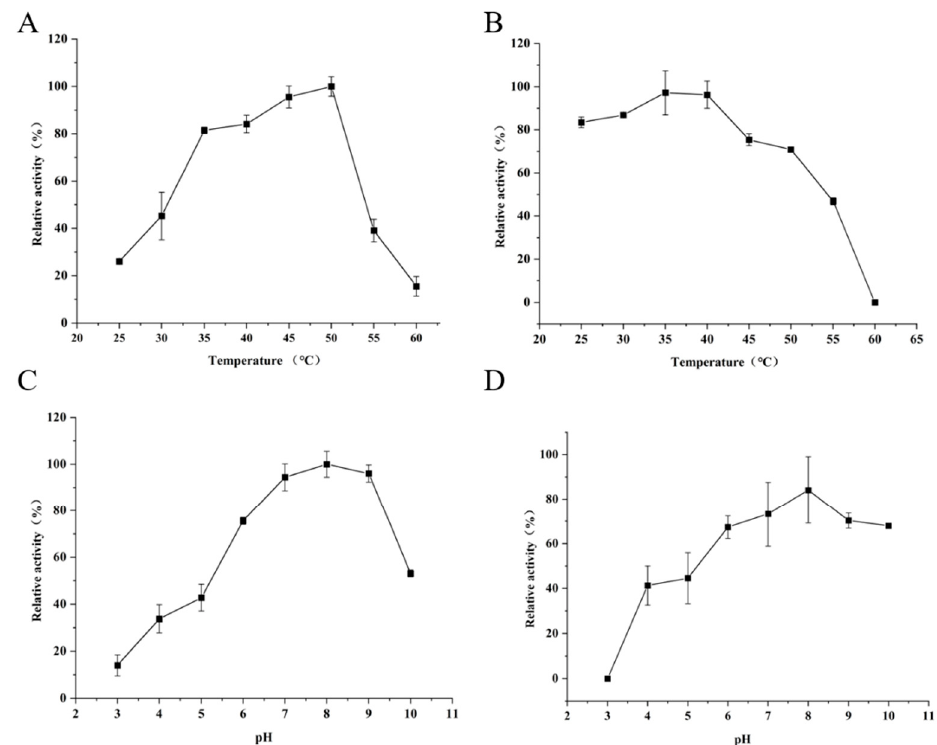
Figure 4. Determination of enzymatic properties of Feruloyl esterase (KoFAE). ( A ) Effect of different temperatures on enzymatic activity of KoFAE. ( B ) The temperature stability of KoFAE. ( C ) Effect of different pH on enzymatic activity of KoFAE. ( D ) The pH stability of KoFAE. The data were acquired in triplicate experiments.